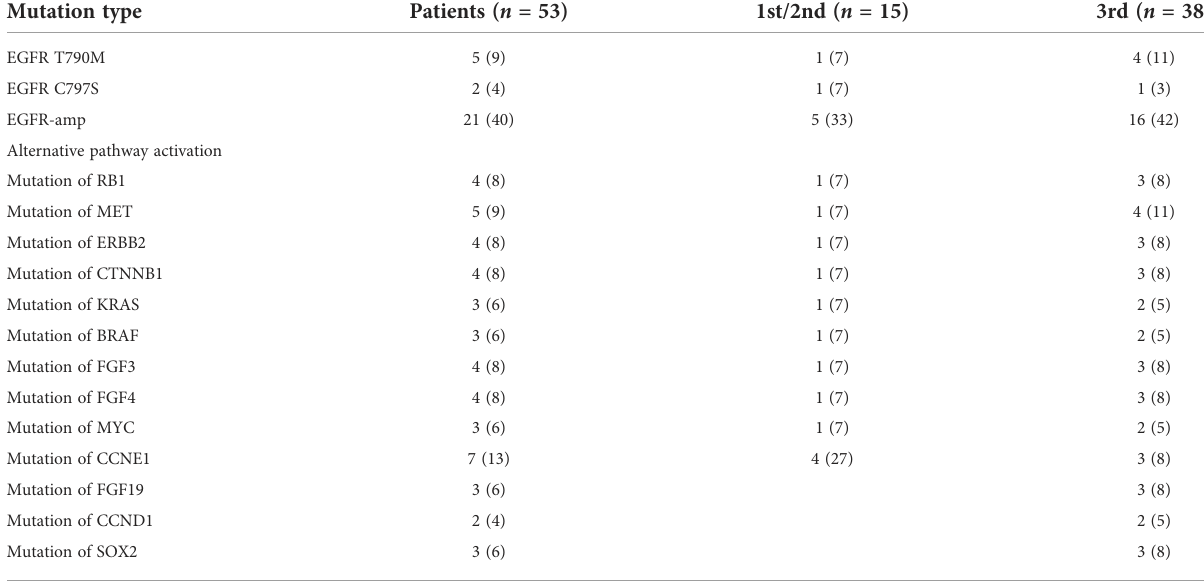
TABLE 2 Potential resistance mechanism to EGFR-TKI in non-small cell lung cancer – leptomeningeal metastases.